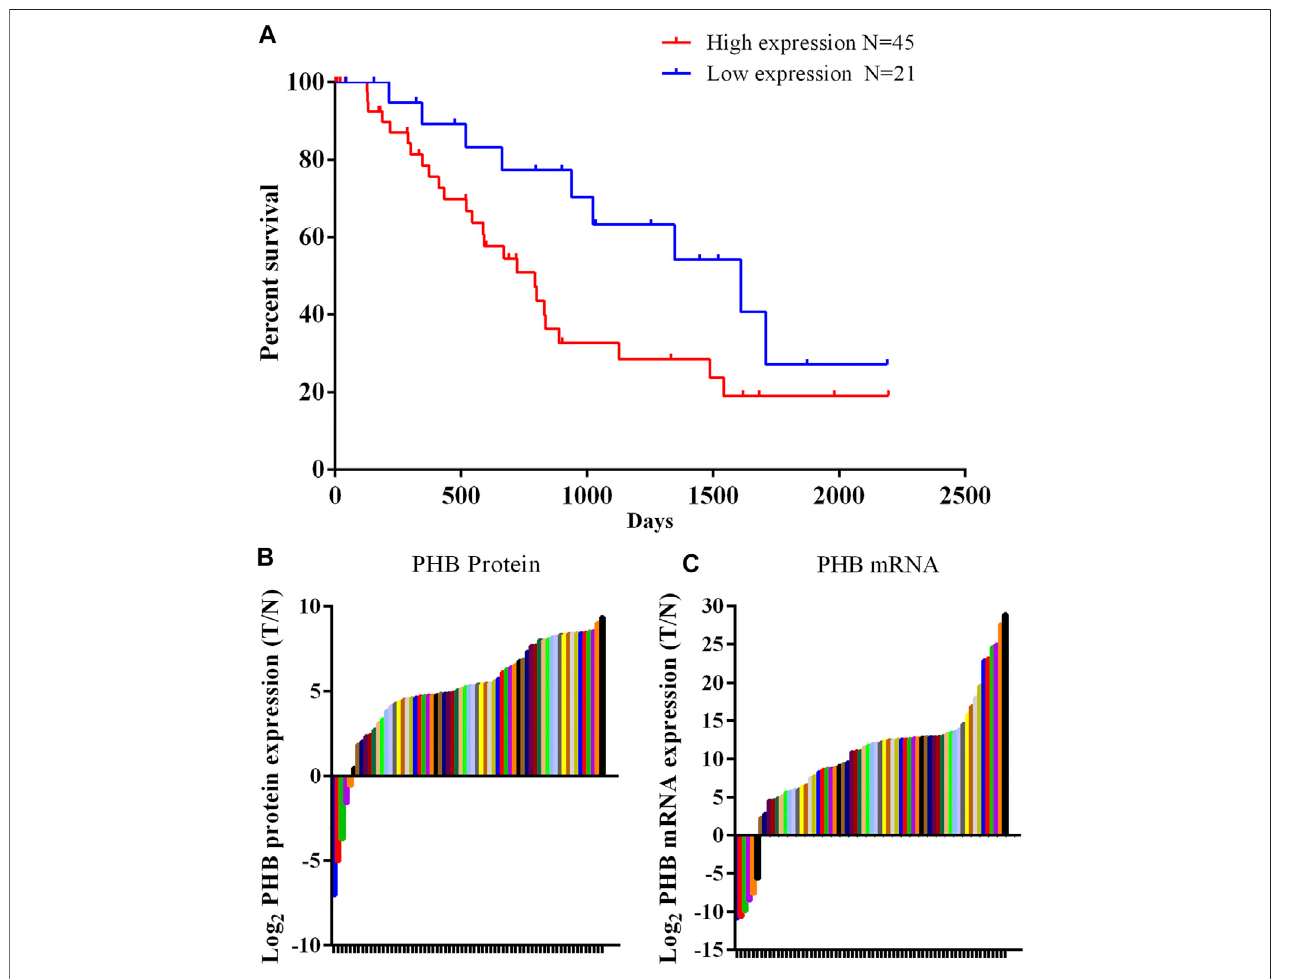
FIGURE 1 | PHB expression in clinical samples and the relationship between PHB expression and the patient survival rate. (A) Patients with low PHB expression level present ahigher survivalrate those withhigh PHB expression level; (B) In66pairs ofclinical samples, PHBprotein expression in 61tumor samples washigher than in adjacent tissues; (C) In 66 pairs of clinical samples, PHB mRNA expression in 60 tumor samples was higher than in adjacent tissues.